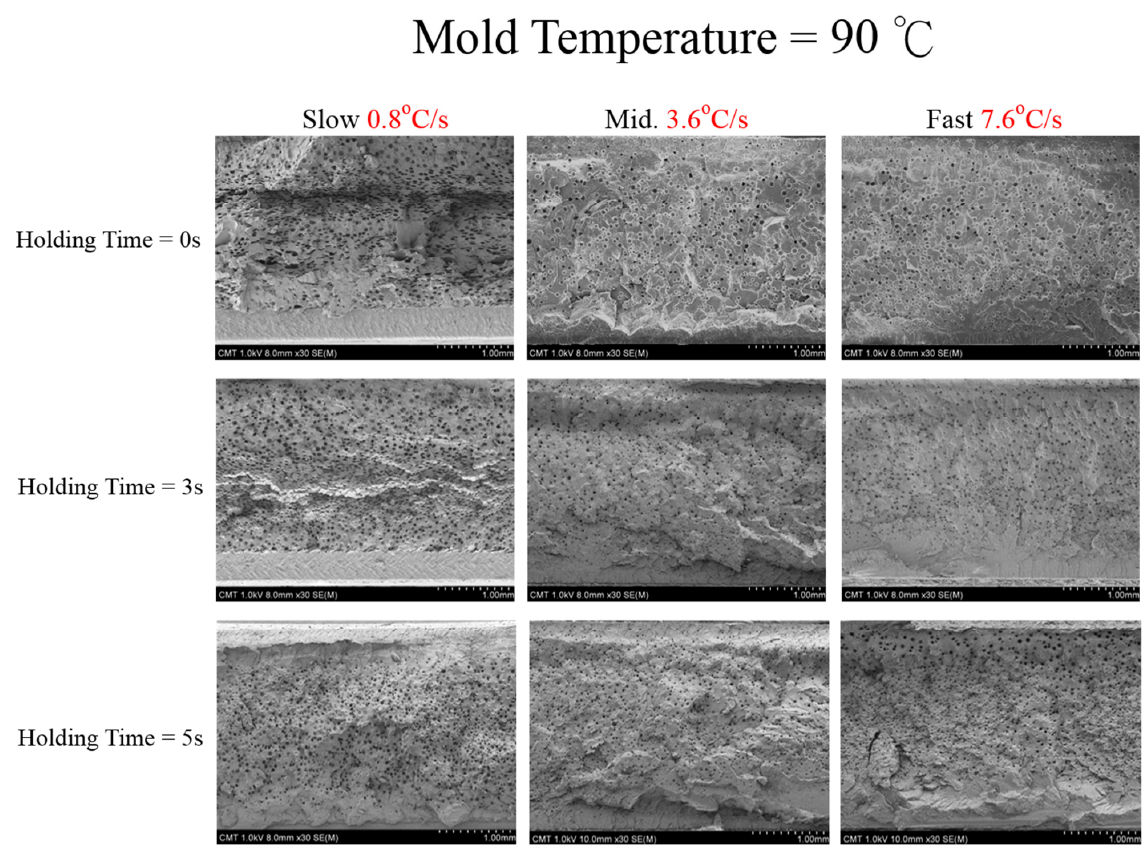
Figure 8. Effect of GCP holding time on foaming morphology under different cooling speeds at 90 °C mold temperature.